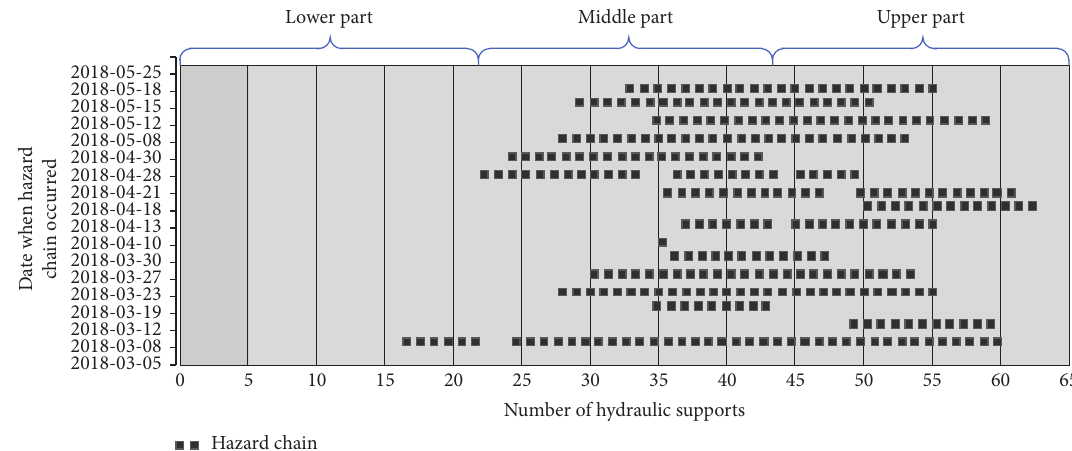
Figure 3: Recorded hazard chain occurrences in the 12124 working face.